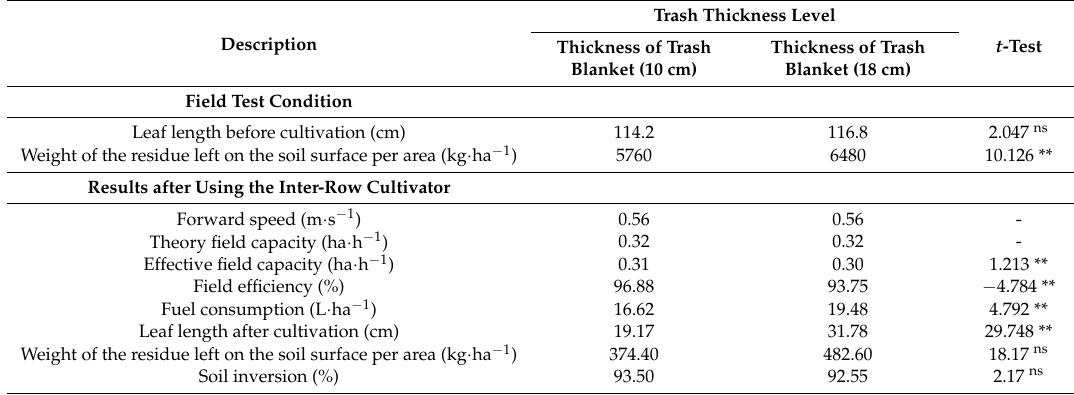
Table 4. The performance test and the practical field test of an inter-row cultivator attached to the 25.3-kW tractor at different thicknesses of the trash